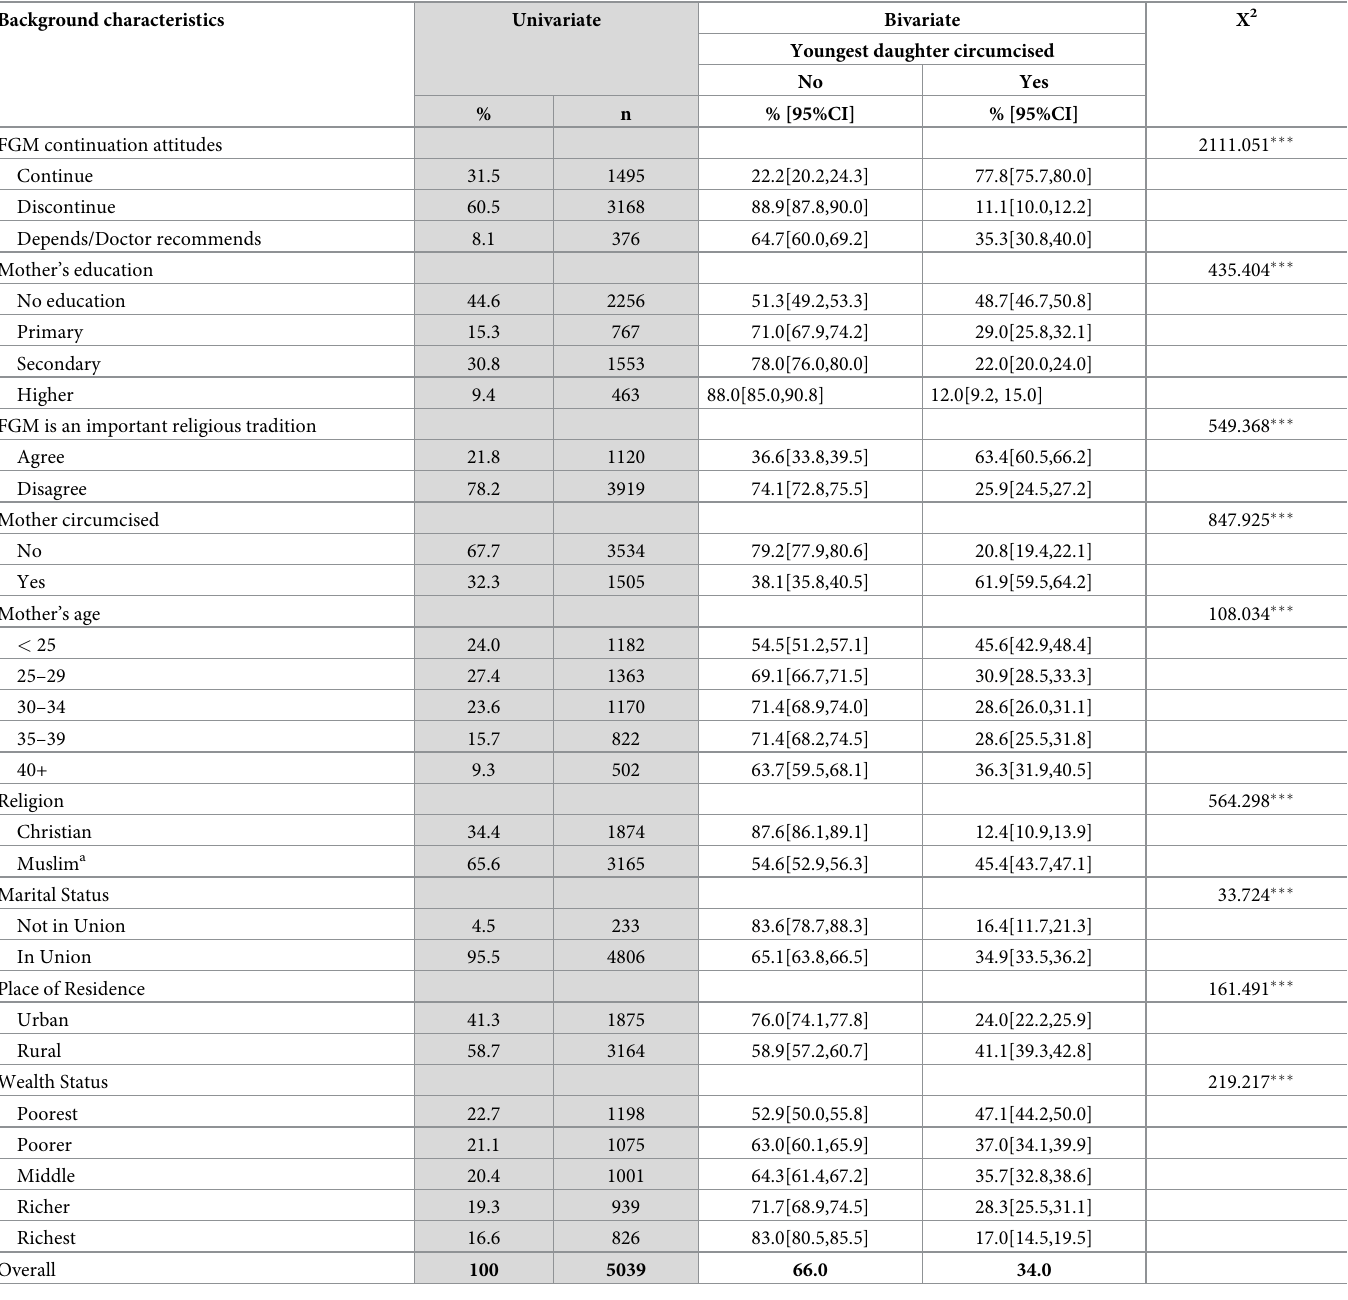
Table 1. Weighted percentage distribution of circumcision among youngest daughters by background